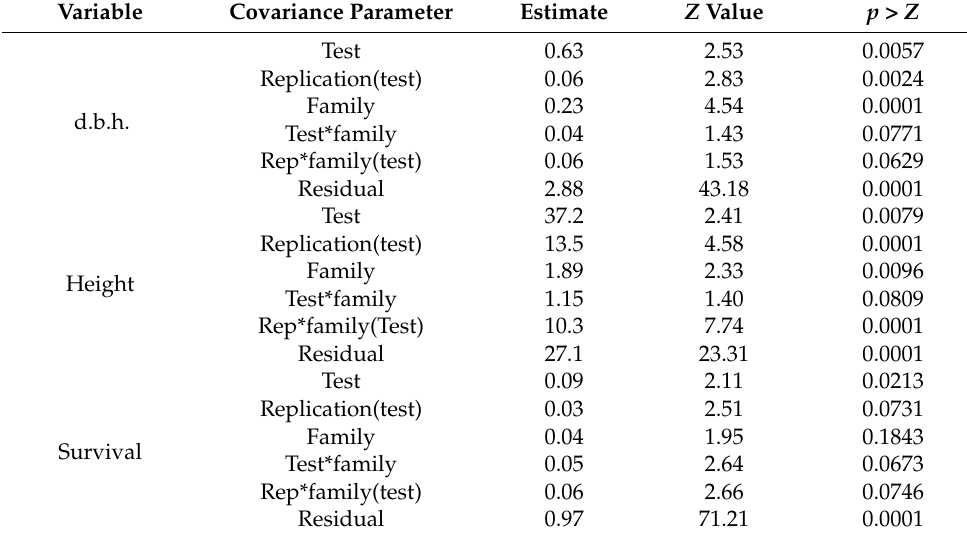
Table 4. Main effect and interaction variances for d.b.h., tree height, and survival across test sites.